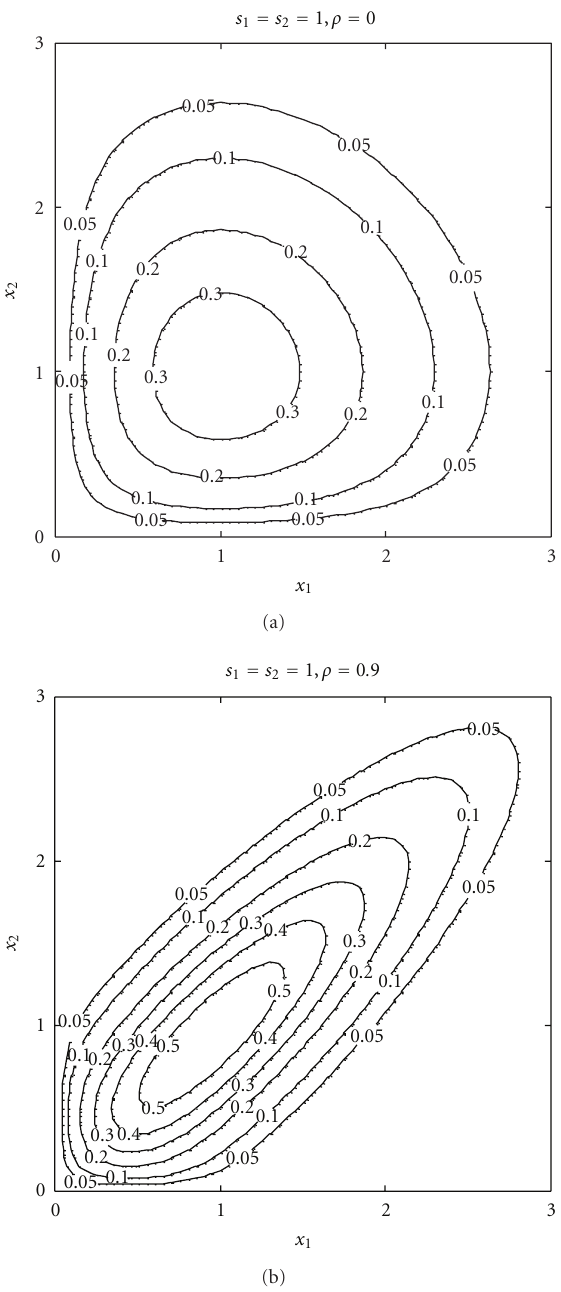
Figure 1: PDF for 2D Rayleigh distributed data, ρ = 0 (a) and ρ = 0 . 9